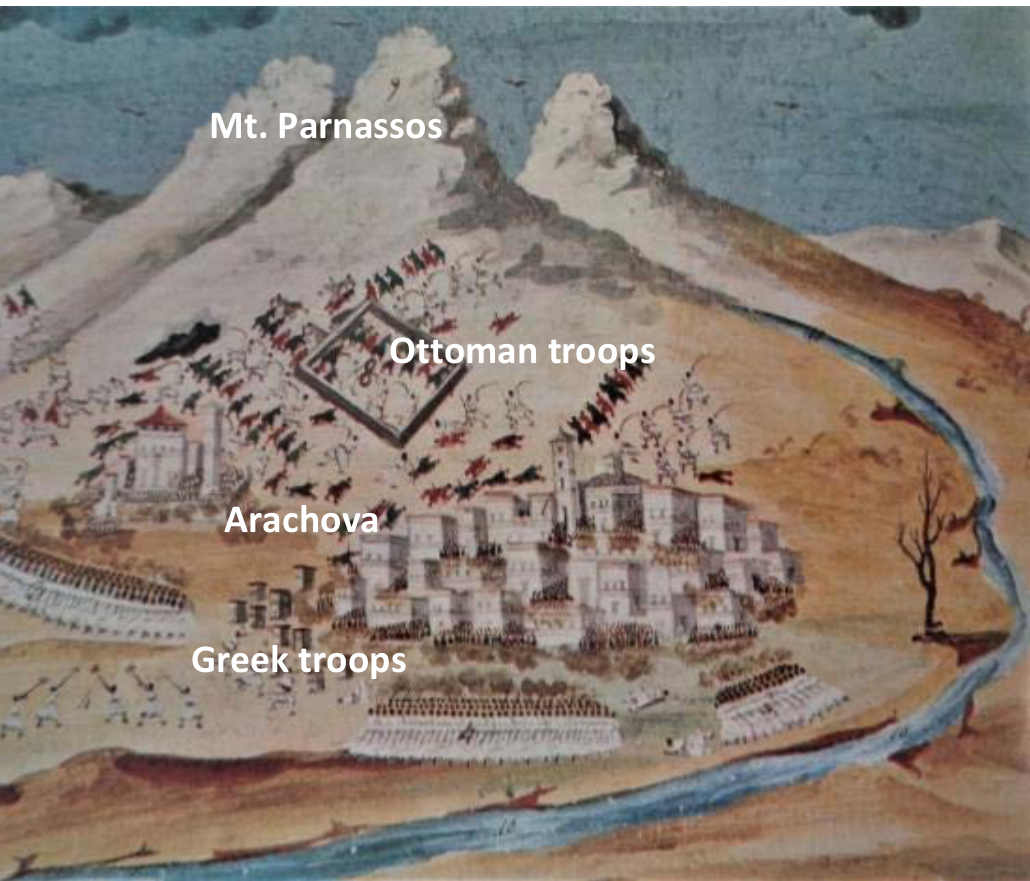
Figure 10. Schematic plot for the battle of Arachova in November 1826 (Batte at Arachova, D. Zografos—I. Makrigiannis, The American School of Classical Studies at Athens, Gennadius Library). The white text labels have been added in this study to denote the relative possitions of the armies.